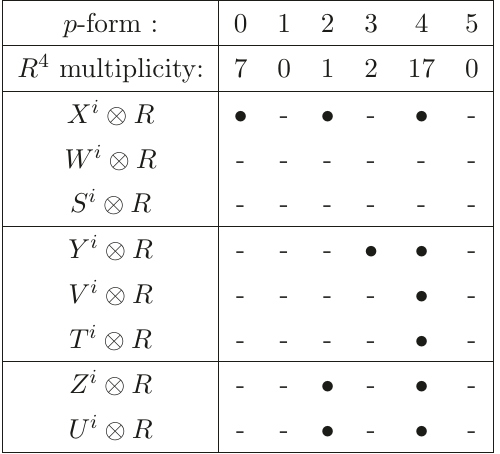
Table 3 . Potential contributions of the terms in table 2 to different p -forms in the M-theoretic